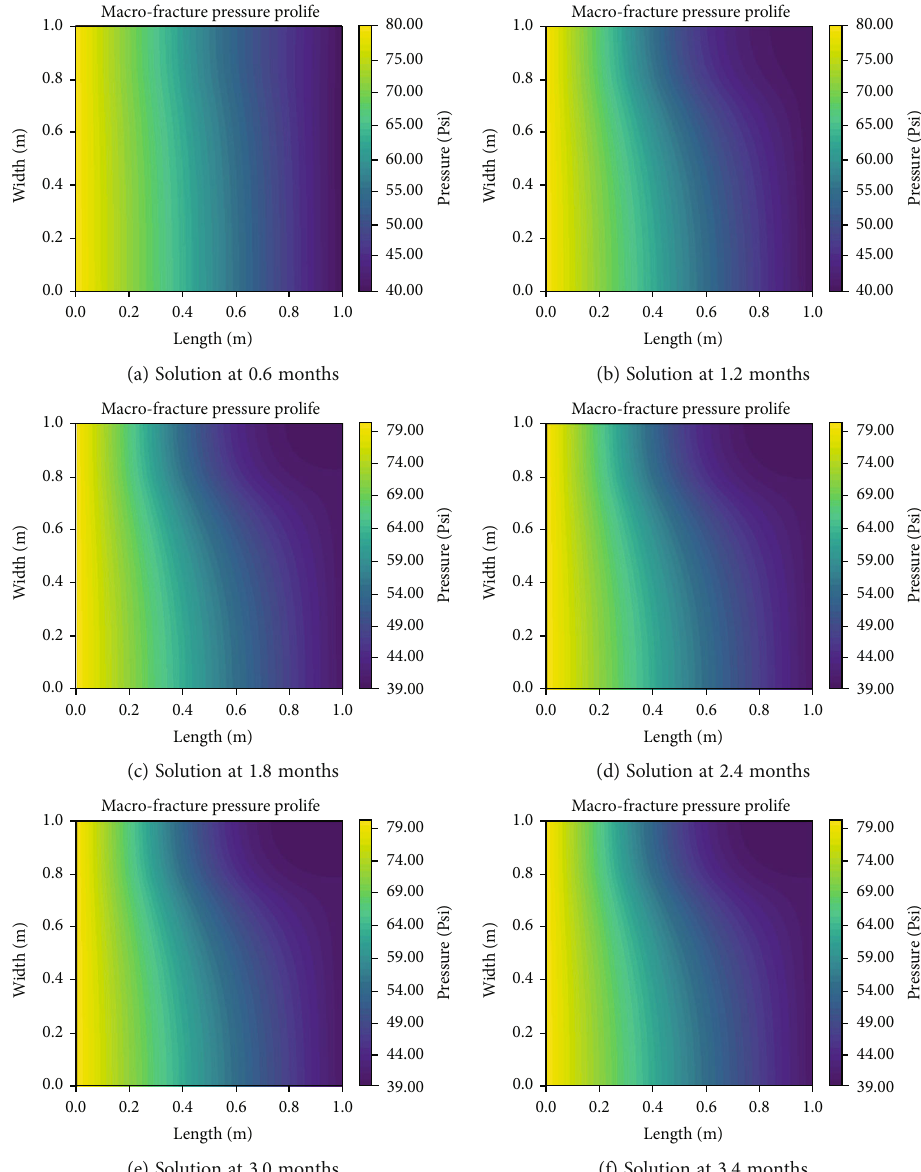
Figure 6: Pressure distribution in the macrofracture domain with increasing time. A quasi-steady state regime observed after 2.4-month